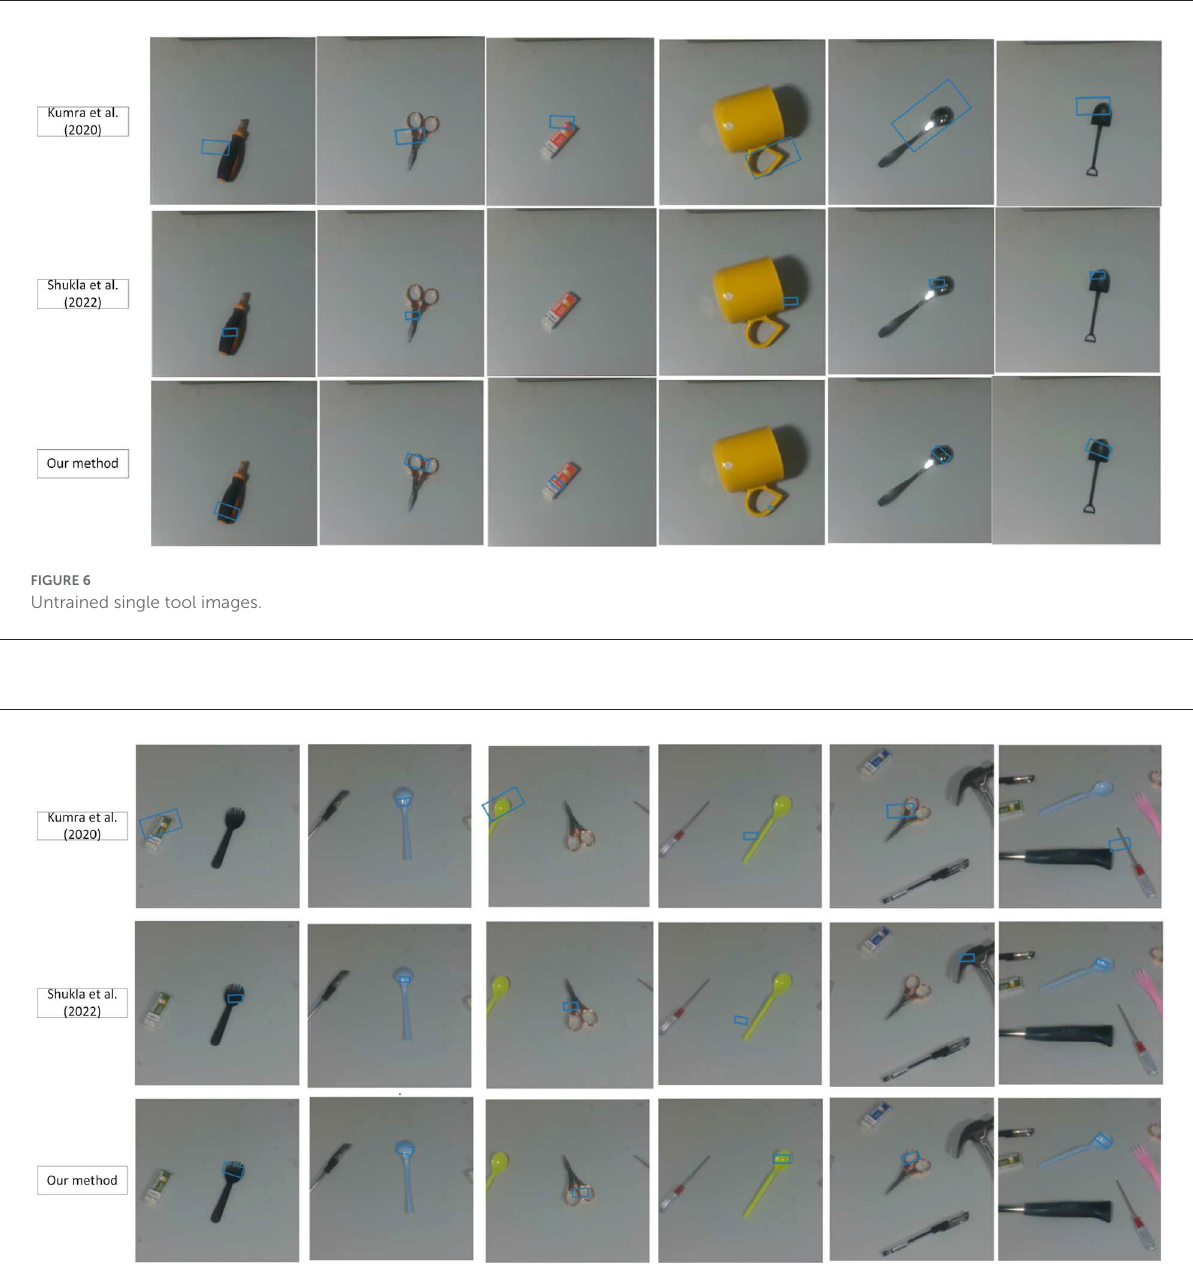
FIGURE7 Untrained multi-tools